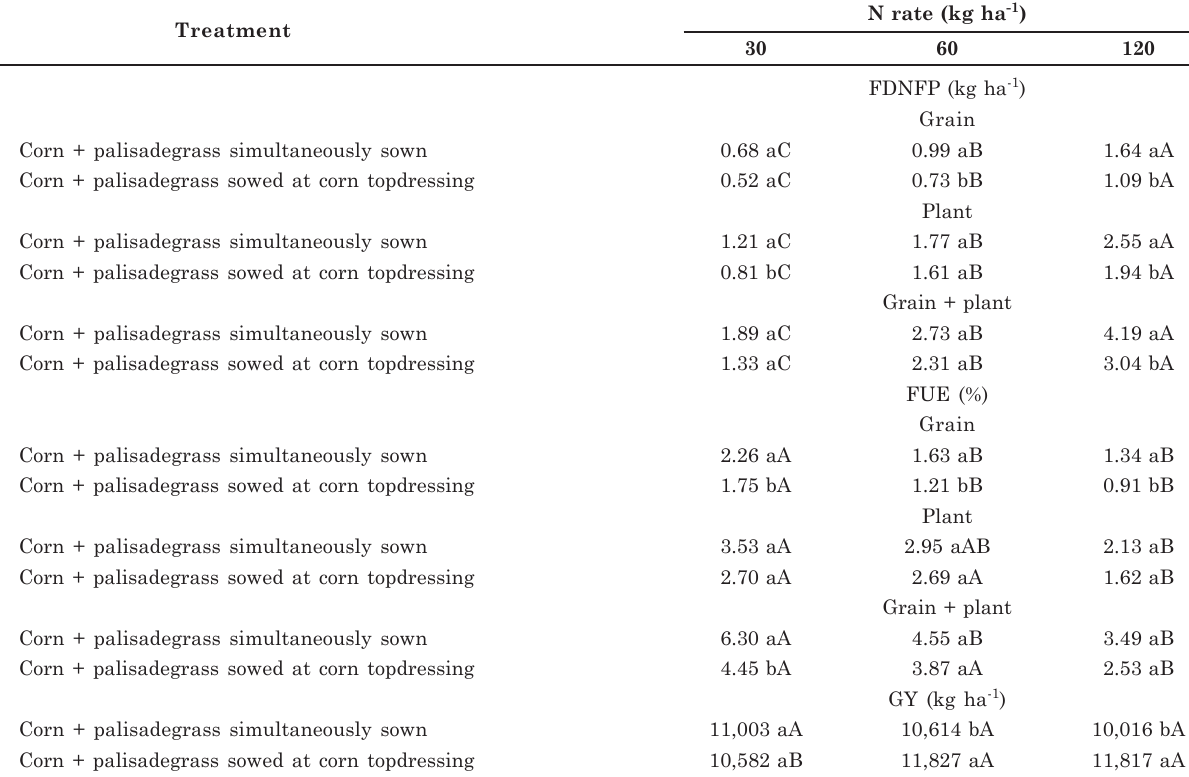
Table 4. Interaction between intercrop sowing time × N rates (source 15 NH 4 NO 3 ) applied to palisade grass for: fertilizer-derived N in the plant (FDNFP), fertilizer use efficiency (FUE) by the grain, plant, and total (grain + plant), and grain yield (GY) of corn sown into straw of palisade grass of two